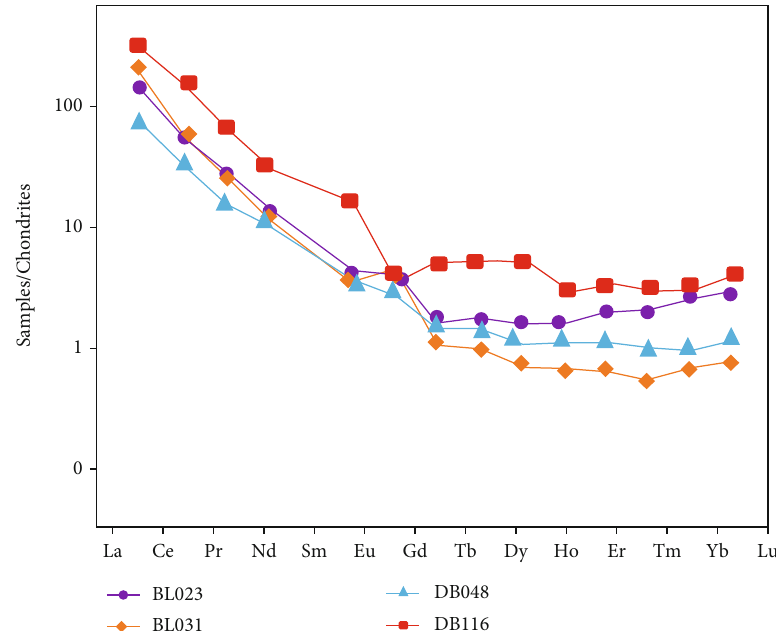
Figure 5: Normalized distribution pattern of rare earth element chondrites.